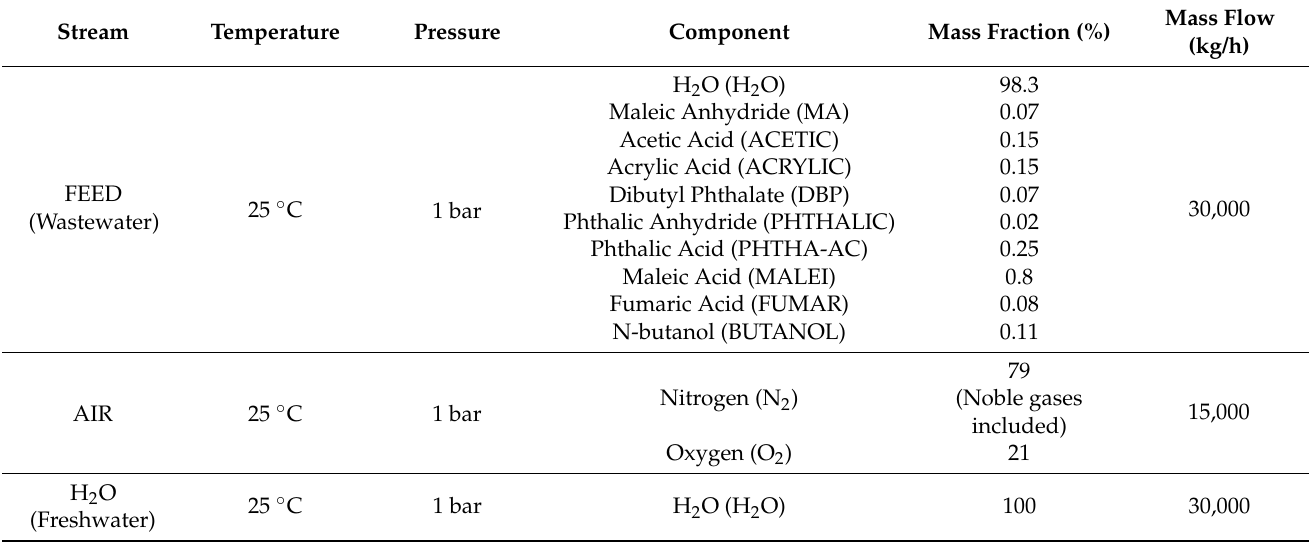
Table 1. Inlet streams parameters and